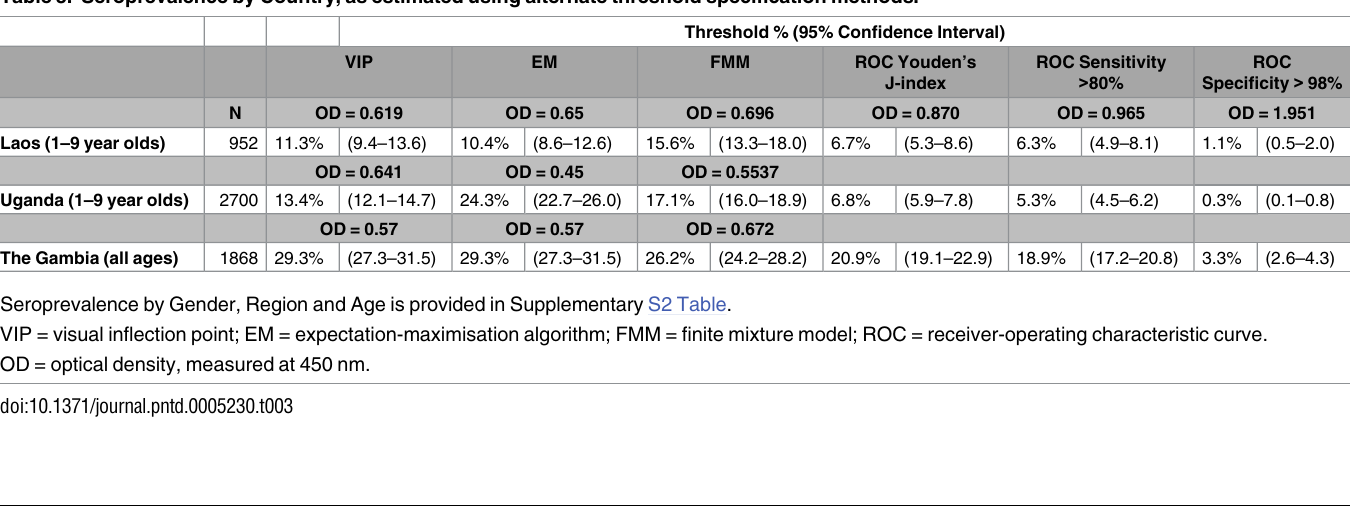
Table 3. Seroprevalence by Country, as estimated using alternate threshold specification methods.